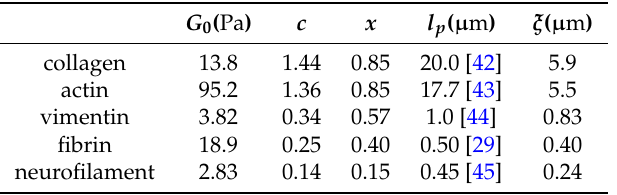
Table 1. Fitting parameters ( c , x ) for collagen, actin, vimentin, fibrin and neurofilament data obtained from experiment [29]. Also shown are the linear modulus G 0 extracted from the original data and used for scaling in Figure 8, the literature values of l p with their source, and the calculated mesh size ξ = l p ( x /2 c )